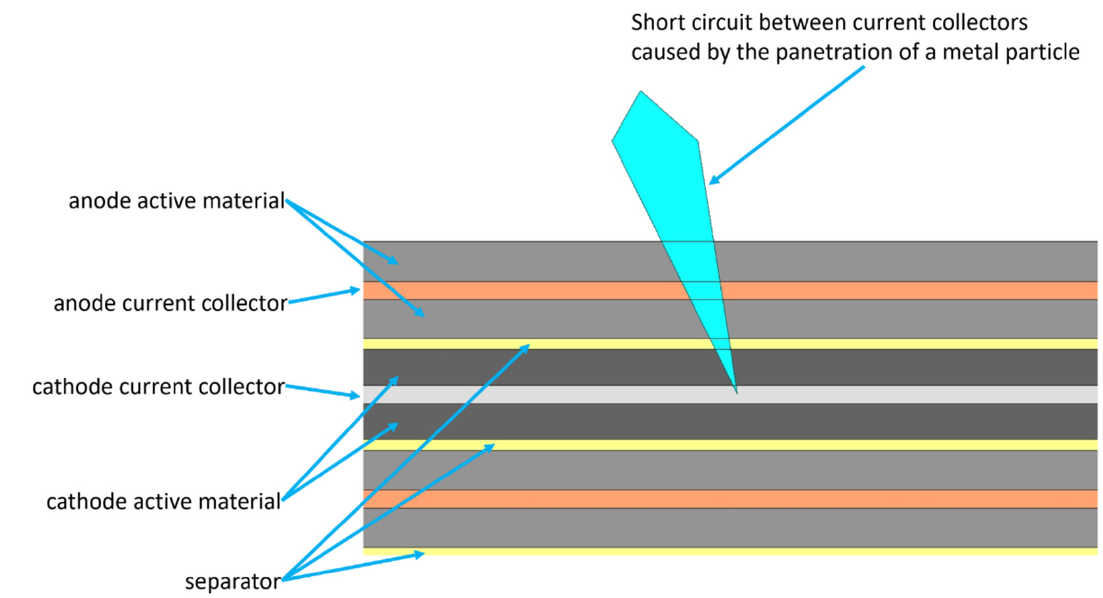
Figure 3. Diagrammatic representation of an internal short-circuit.